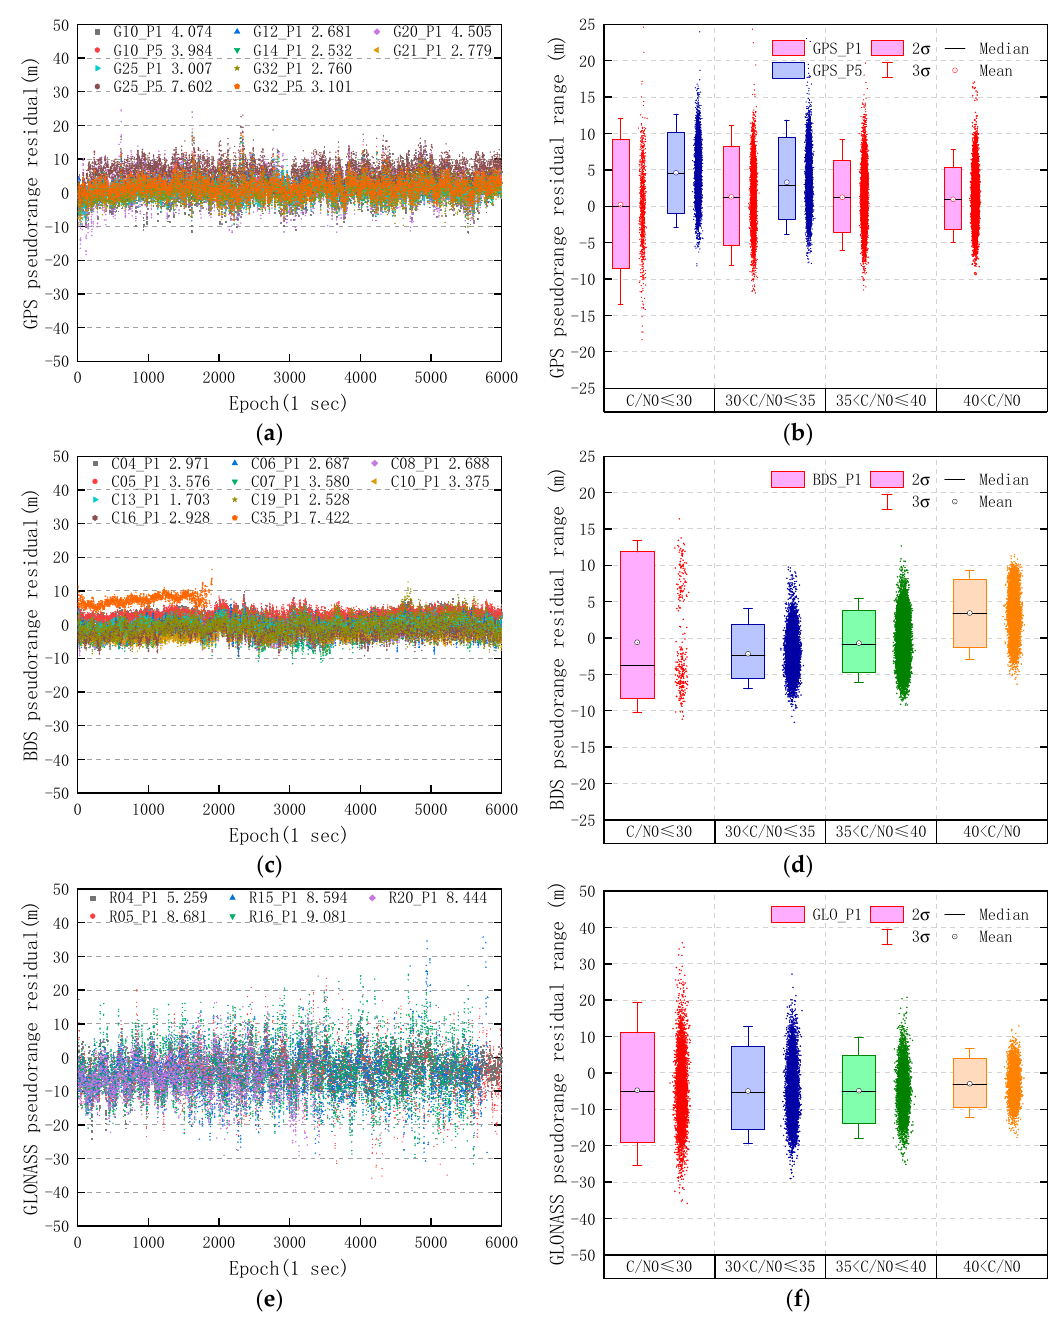
Figure 5. Pseudorange residuals of observed GPS, BDS, and GLONASS satellites in static data collected by the Huawei Mate30. ( a ) Pseudorange residual of GPS; ( b ) pseudorange residual range of GPS; ( c ) pseudorange residual of BDS; ( d ) pseudorange residual range of BDS; ( e ) pseudorange residual of GLONASS; and ( f ) pseudorange residual range of GLONASS. The value after the satellite pseudo random noise (PRN) number is the RMS of pseudorange residuals.